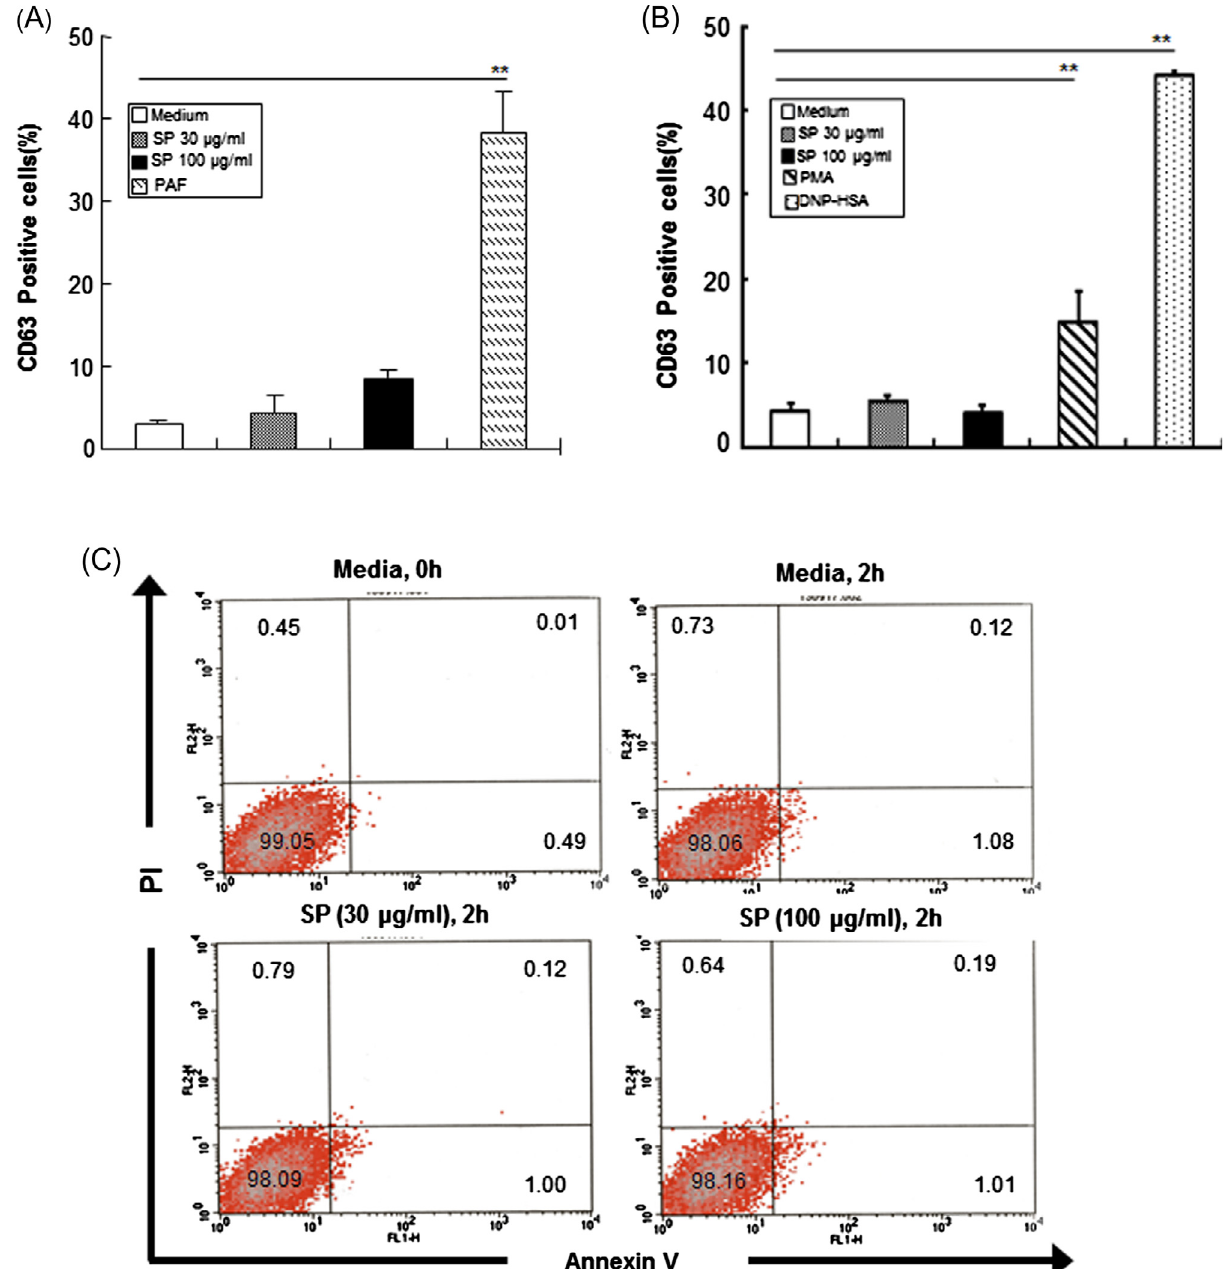
Figure 1. E. histolytica -derived secretory products (SPs) of pathogenic amoebae do not induce cell death or exocytosis in mast cells. (A) Percentage of CD63-positive cells in HMC-1 cells incubated with SPs or platelet-activating factor (PAF) (5 l M). ( n = 3) (B) Percentage of CD63-positive cells in bone marrow-derived murine mast cells incubated with SPs, phorbol 12-myristate 13-acetate (PMA) (50nM) or DNP- HSA (250 ng/mL). ( n = 4). (C) Flow cytometry analysis of HMC-1 cell death after stimulation with or without SPs. ( n = 4). All reactions were performed in triplicate measurements of each experiment. All data are presented as the mean ± SEM of at least three independent experiments. The asterisks indicate the results of comparisons with the controls (** p <